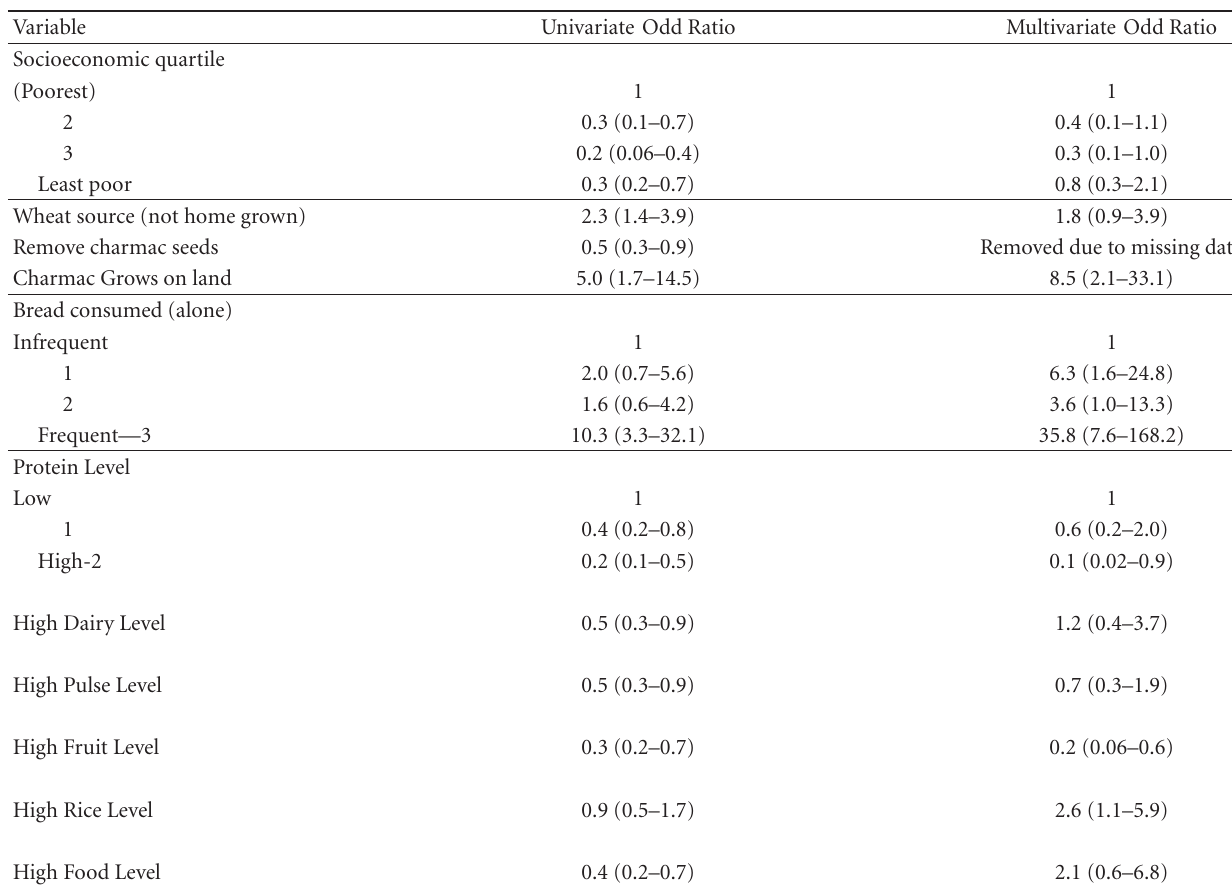
Table 2: Univariate and multivariate analysis of potential exposure factors for hepatic veno-occlusive disease in Gulran District, Afghanistan, 2008. Odds ratios presented with 95% confidence intervals in parentheses.